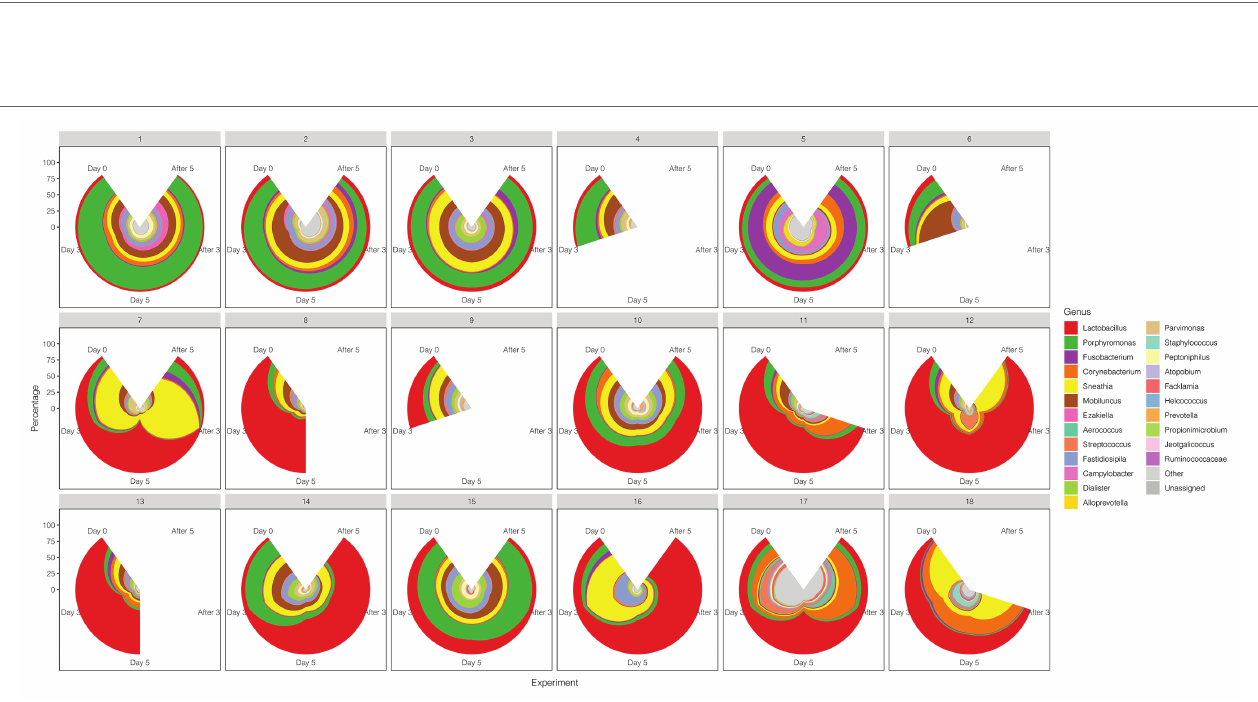
FIGURE 1 | Diversity of rhesus macaque vaginal microbiota in control and test groups. (A) Composition of initial vaginal microbiota (Day 0). (B) The mean values of the primary genera of the initial vaginal microbiota (Day 0). (C) Alpha diversity of microbiota as measured using Shannon index, Simpson, and inverse Simpson of genus level 16S rRNA gene phylotypes. Control, blue; Test, red. The mean values of the five times of follow-up in two groups are connected by blue and red lines, respectively, and the gray area is the standard error of linear regression.